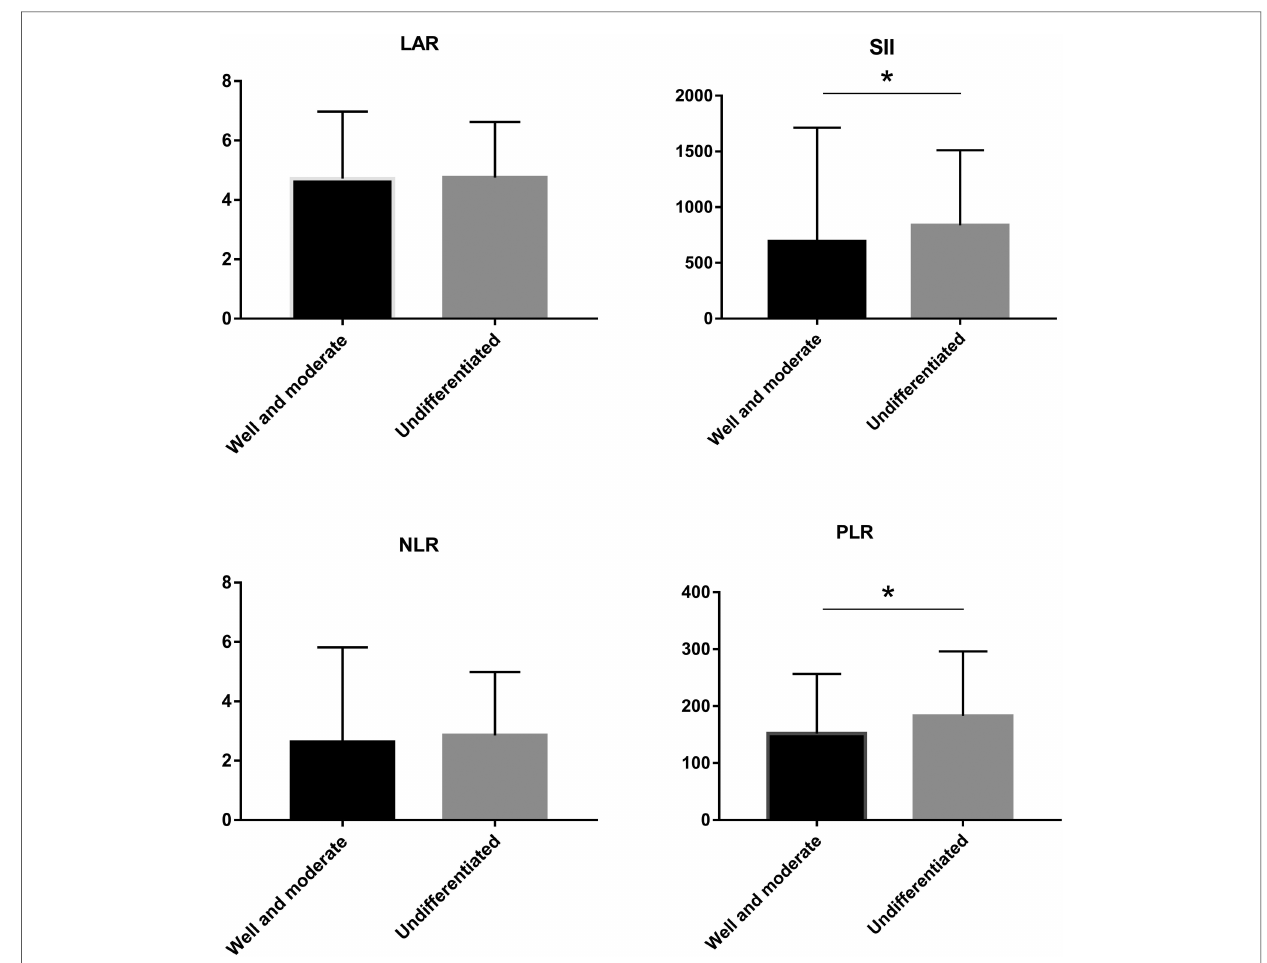
FIGURE 3 LAR, NLR, PLR and SII levels of CRC patients in different tumor differenation degree * p <0.05.